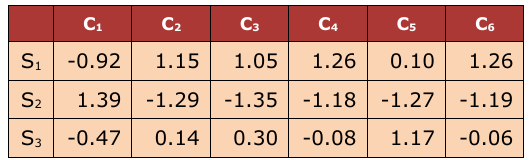
Table 5. Z matrix